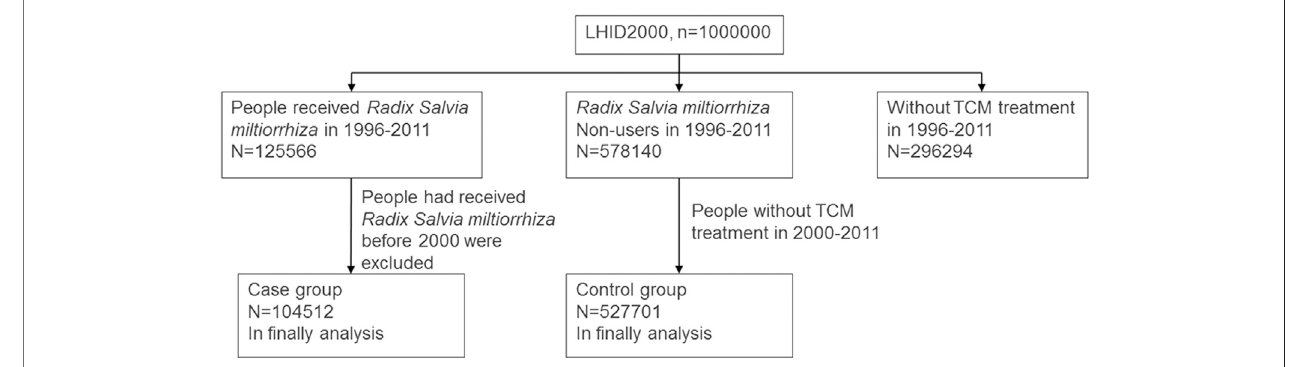
FIGURE 1 | Study fl ow chart. LHID, Longitudinal Health Insurance Database.